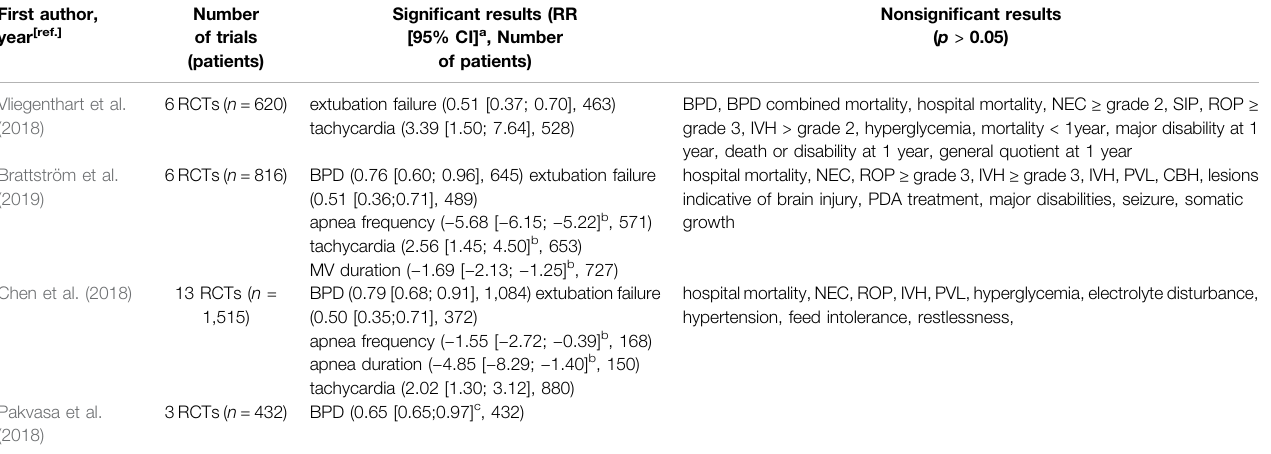
TABLE 5 | Results for Higher vs. Lower Doses of Caffeine in